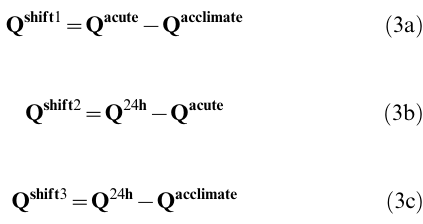
Figure 2. Water temperatures in the preference chamber during the preference tests for the three acclimation temperatures. Mean (SD, n=6) water temperatures in the five temperature zones during the non-gradient observation, installation of the temperature gradients and acute preference observations are presented for the tests conducted with fish acclimated to 18 u C (A), 22 u C (B) and 28 u C (C). Water temperatures during the 24 h preference observation equalled the water temperatures during the acute preference observations (not